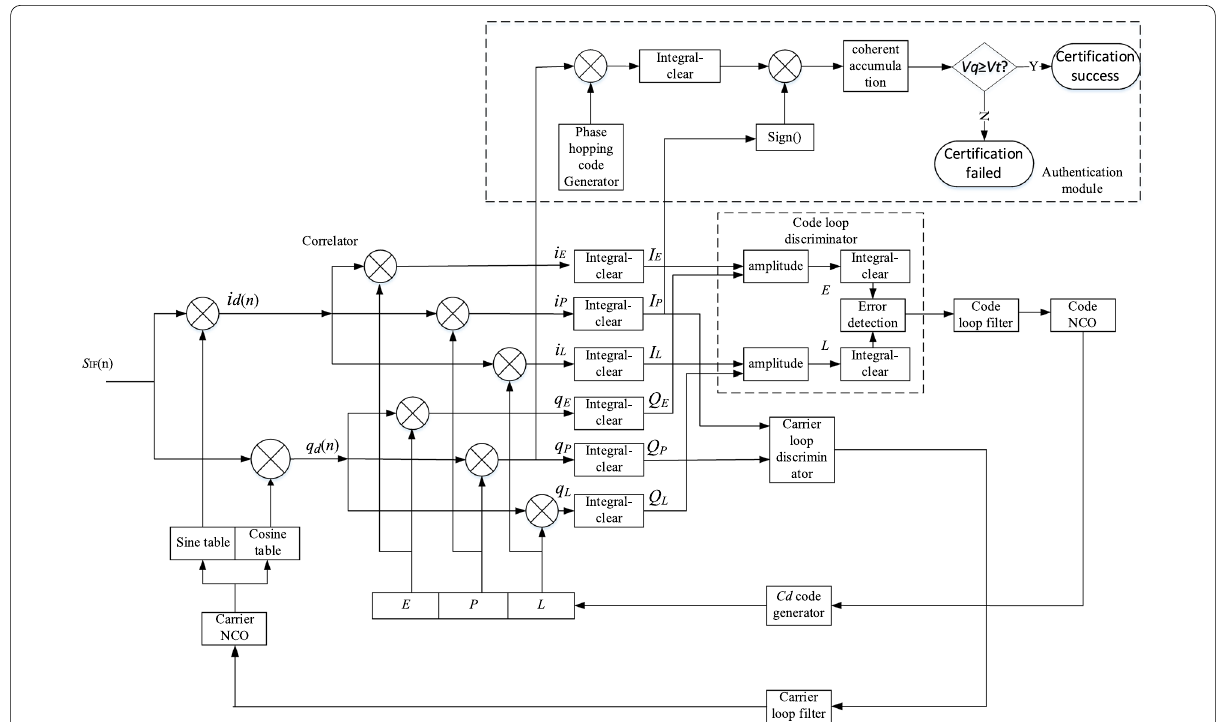
Fig. 5 Schematic diagram of using data-channel signal